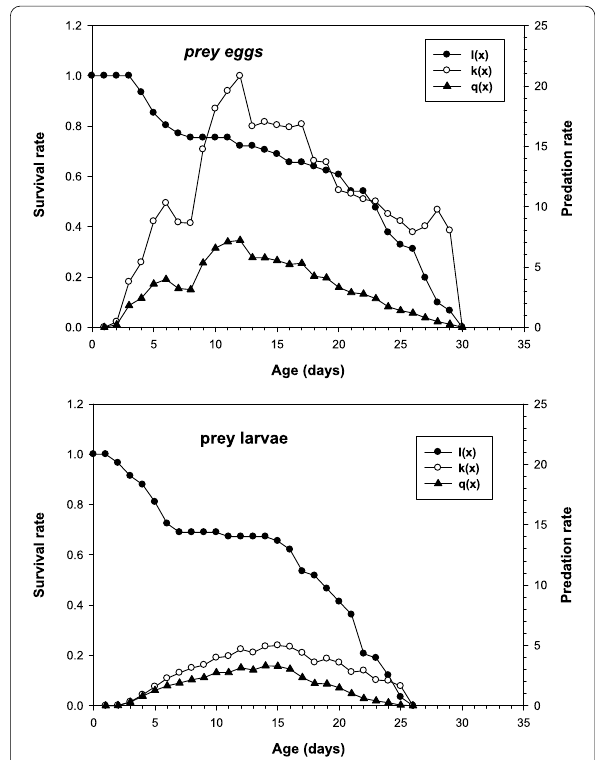
Fig. 6 Age-specific predation rate ( k x ), age-specific net predation rate ( q x ) and age-specific survival rate ( l x ) of Blattisocius mali on eggs and larvae of Tyrophagus putrescentiae